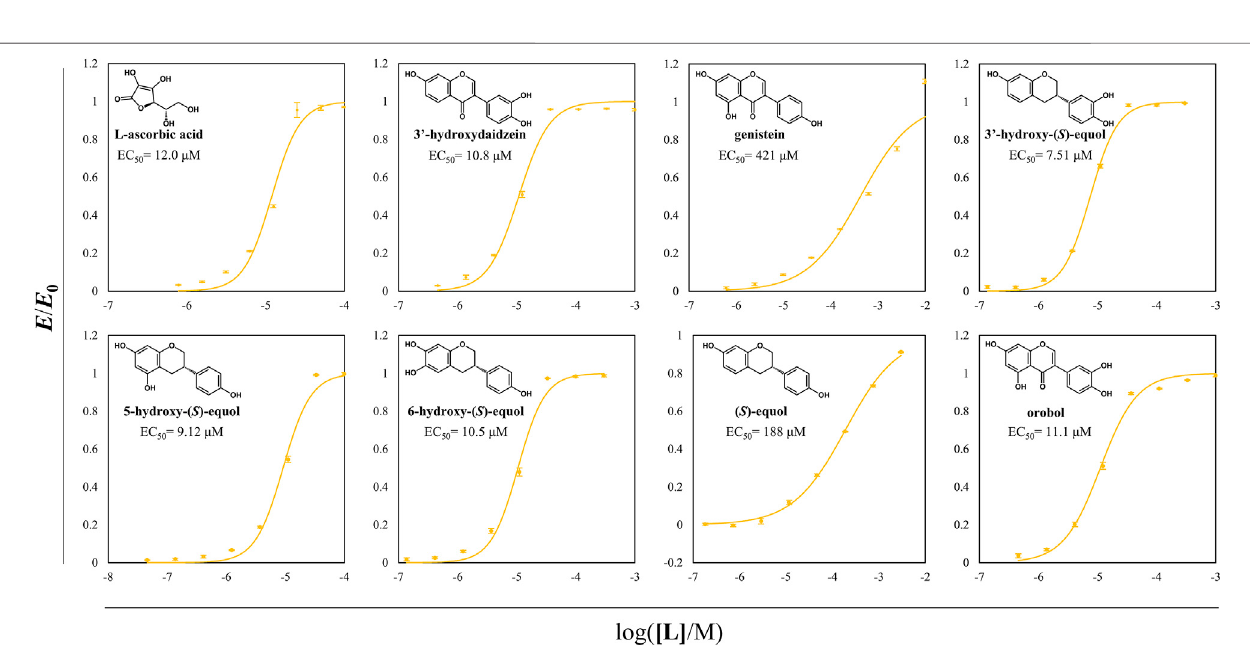
FIGURE8| DPPHradicalscavengingassayofprobabledirectantioxidativecompoundsincludingHEs.DPPHradicalscavengingactivityofdirectantioxidantswas assessed according to thechanges inthe value of OD 520 /OD 495 . EC 50 ofDPPH radical scavenging ofeach compound waswritten inthe plots. The normalized OD ratio change values were expressed as yellow circles, and the lines of yellow color were the regressed values. All the data were recorded using mean values with standard deviations for